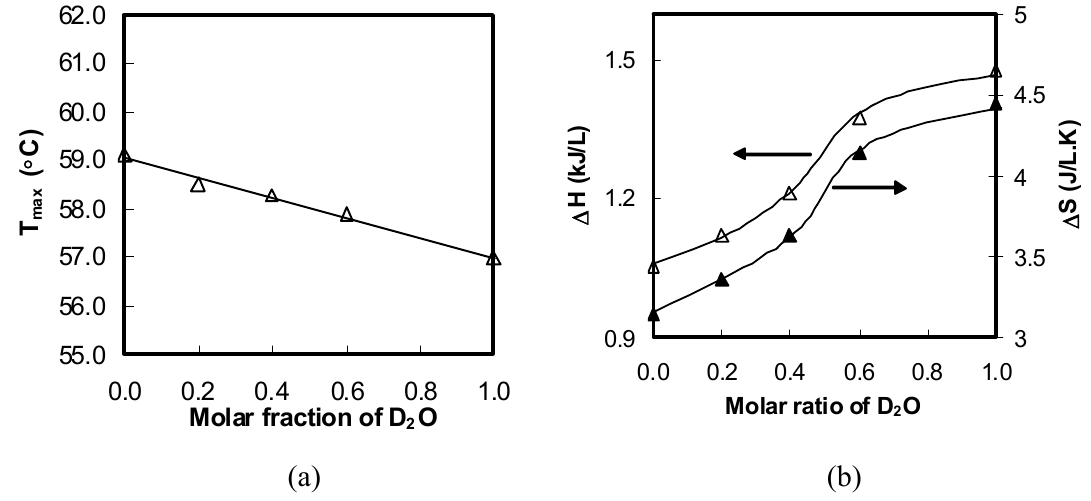
O: ( a ) T ; ( b ) Δ H and Δ 2 max